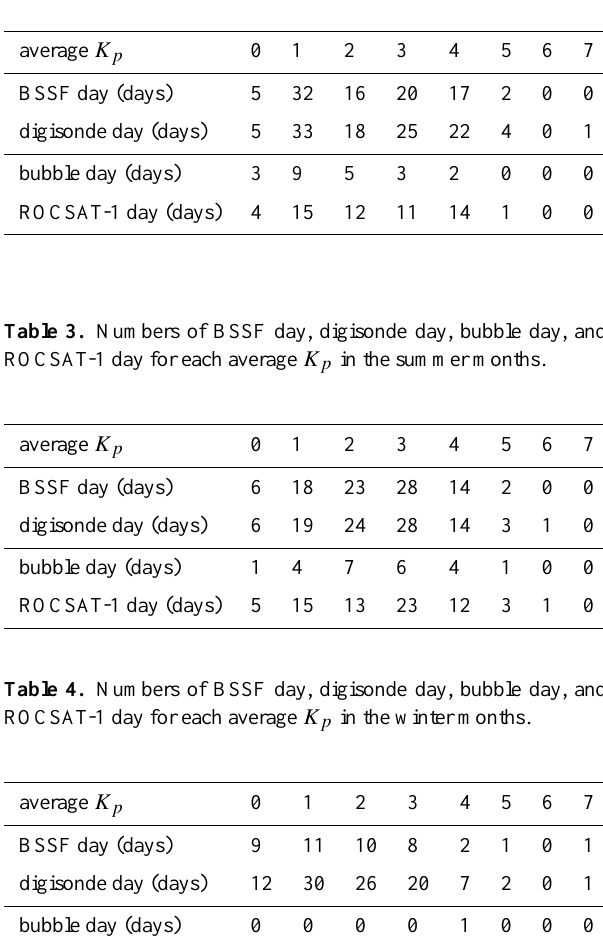
Table 2. Numbers of BSSF day, digisonde day, bubble day, and ROCSAT-1 day for each average K p in the equinoctial months.